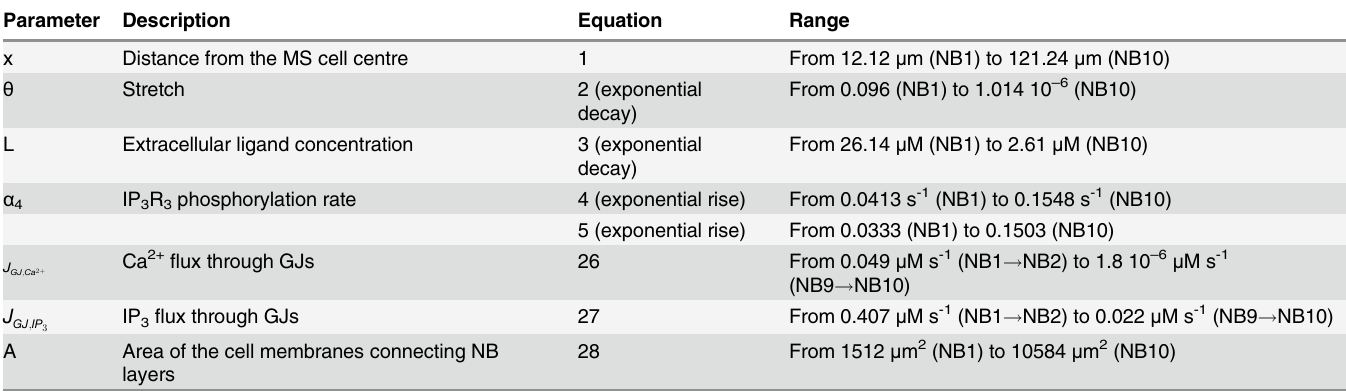
Table 3. Location-dependent parameters with respect to the MS